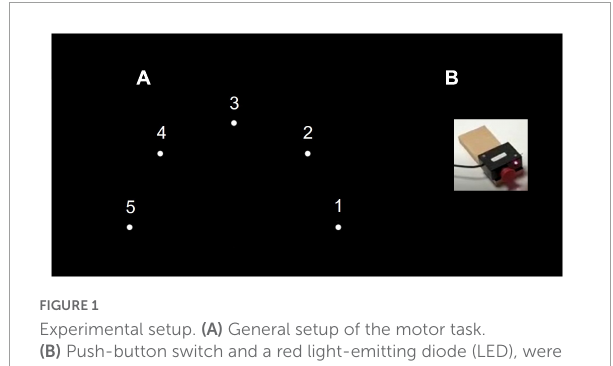
FIGURE1 Experimental setup. (A) General setup of the motor task. (B) Push-button switch and a red light-emitting diode (LED), were attached to the tabletop in a 38-cm radius half circle, numbered right to left from 1 to 5.